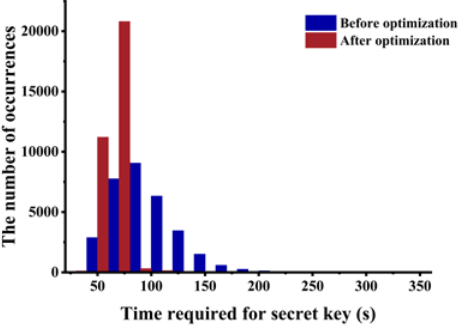
Figure 12. The distribution of the attack time.